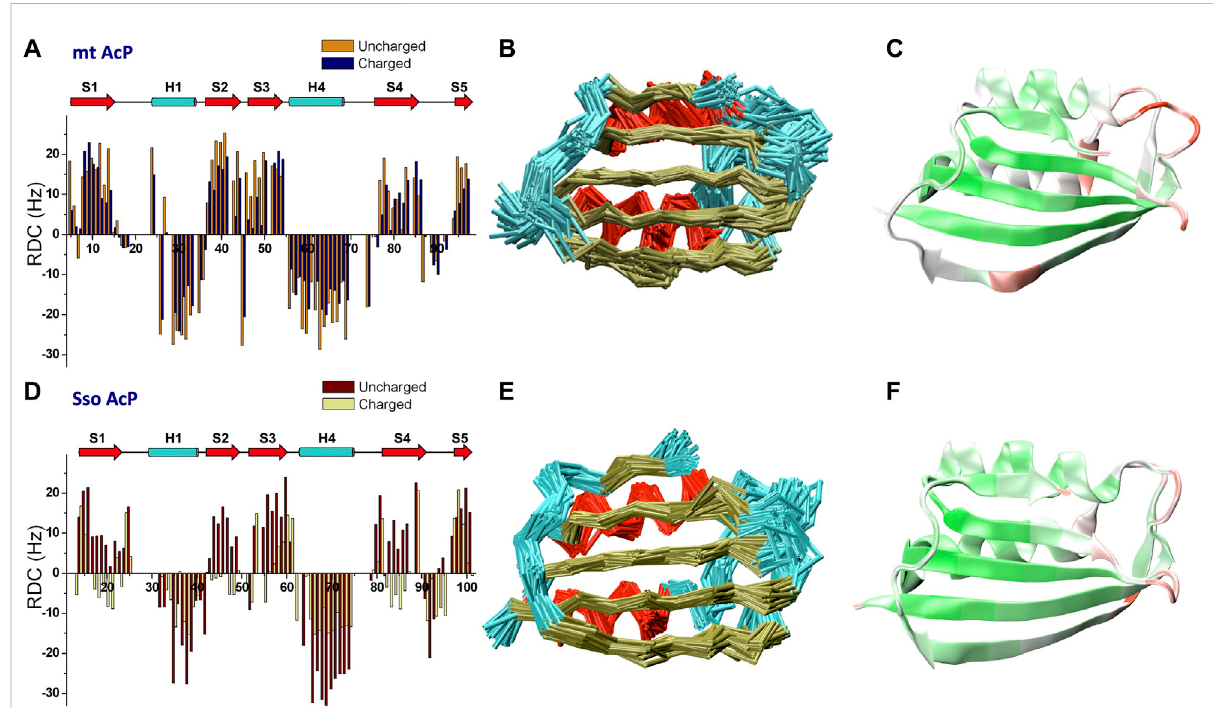
FIGURE 2 MicroseconddynamicsfromNMRresidualdipolarcouplings. (A) N-HRDCsmeasuredformtAcPat37 ° Cusingchargedandunchargedbicelles (Q factor 0.40). (B) Structural ensemble of mt AcP calculated using replica-averaged NMR-restrained MD incorporating 146 N-H and 192 C-N RDC values measured at 37 ° C. Red, gold and cyan colours for the C α -traces indicate α -helixes, β -strands and loops, respectively. (C) RMSF values of the structural ensemble of mt AcP at 37 ° C plotted onto the structure. Color code range from low (green) to high (red) RMSF values. The corresponding RMSF graph is shown in Supplementary Figure S7. (D) N-H RDCs measured for Sso AcP at 80 ° C using charged and uncharged stretchedgels(Qfactor0.68). (E) StructuralensembleofSsoAcPcalculatedusing144 N-Hand176 C-NRDCvaluesmeasuredat80 ° C.Colourcode asinpanelB. (F) RMSFvaluesofthestructuralensembleofSsoAcPat80 ° Cplottedontothestructure. ColourcodeasinpanelC.The corresponding RMSF graph is shown in Supplementary Figure